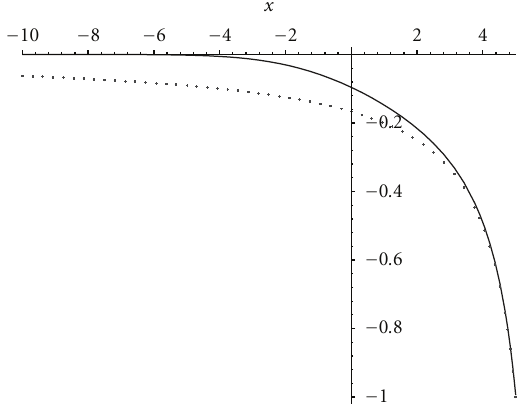
Figure 1: Optimal controls u ∗ t (dotted line) and u ∗ (solid line) 1 =∞ when x ∈ ( − 10,5), b 0 = q 0 = σ 0 = μ = 1, and d = t 1 =